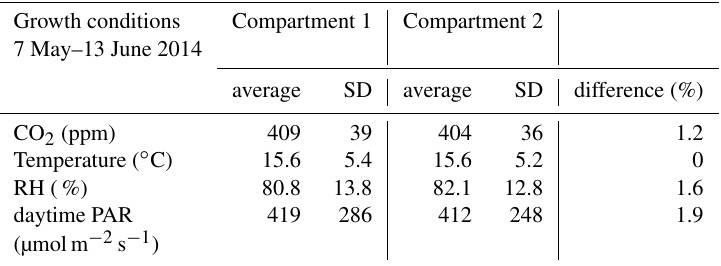
Figure 1. Schematic of the automated gas exchange measurement setup. Note that for simplification the setup is shown for two chambers, but was extended to nine leaf chambers and one empty chamber measured in sequence. Leaf chambers were made of cylindrical Plexiglas coated with a thin Teflon layer. Leaf chambers always remained open, except during measurements when a movable lid was automatically closed (see further details in the Methods section). The direction of the airflow is indicated by the small arrows. Table 1. Before stress growth conditions for black locust. Average CO 2 concentration, temperature, relative humidity (RH) and daytime photosynthetically active radiation (PAR>100µmolm − 2 s − 1 ) including the corresponding standard deviation in the two greenhouse com- partments between 7 May and 13 June 2014, before the start of the first heatwave. Differences in growth conditions between the two greenhouse compartments are given in